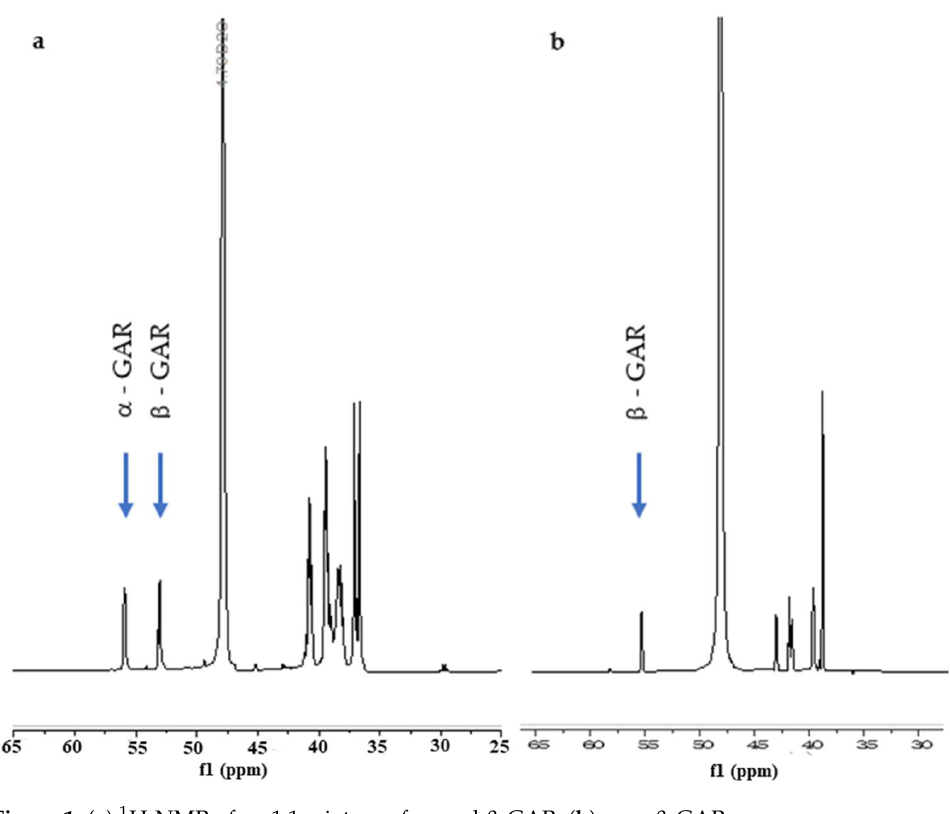
Figure 1. ( a ) 1 H-NMR of a ~1:1 mixture of α - and β -GAR; ( b ) pure β -GAR.